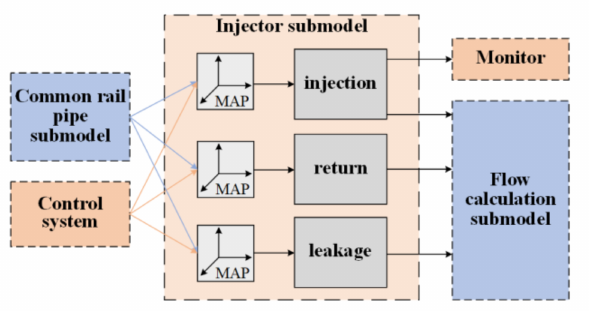
Figure 7. The development process of the injector submodel.